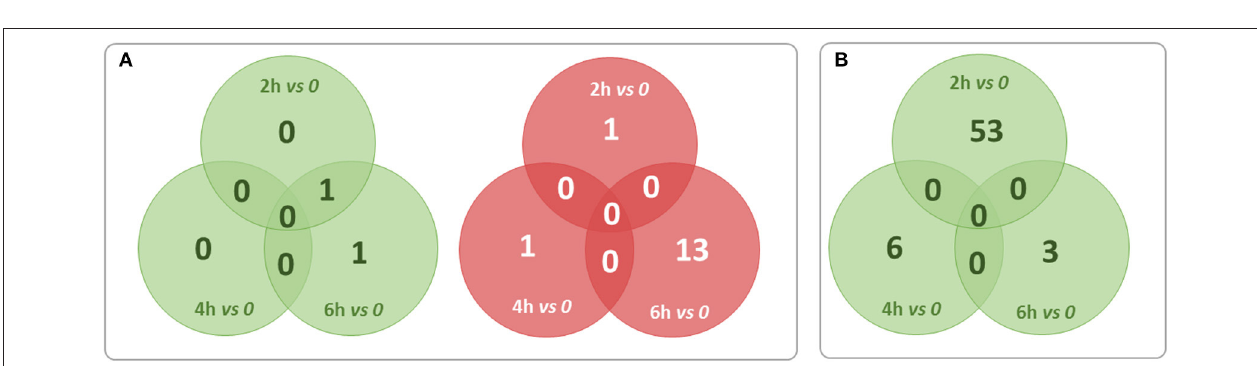
FIGURE 3 | Summary of overlaps between differentially expressed transcripts only in the CF set (A) and only in non-CF set (B) at each of the respective time points against non-infected time point (0 h). Red circles represent down-regulated transcripts and green circles represent up-regulated transcripts. No transcripts were found down-regulated exclusively in non-CF